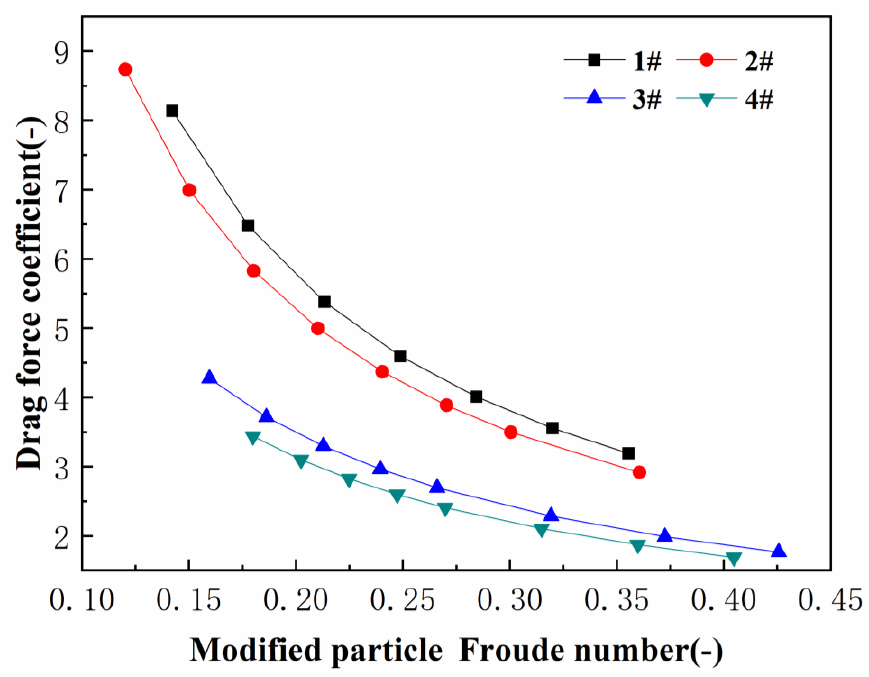
Figure 8. The relationship between drag force coefficient and modified particle Froude number.